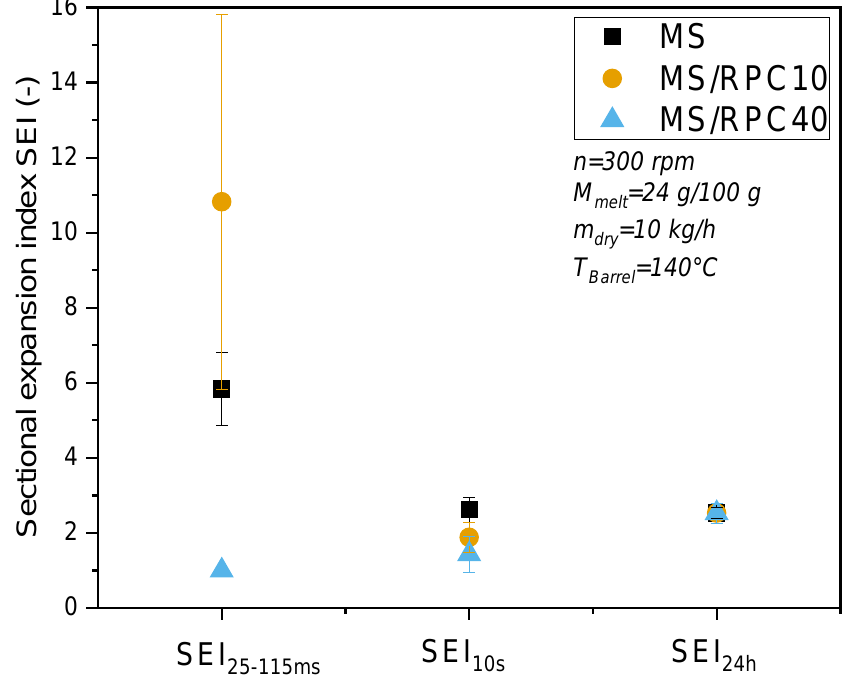
Figure 2. Initial, intermediate and final sectional expansion indices (SEI 25–115ms , SEI 10s , SEI 24h ) of maize starch (MS) extruded as a pure component or in blends with 10 or 40 g/100 g (w.b.) rapeseed press cake (RPC). Samples were processed at a barrel temperature (T Barrel ) of 140 °C, a mass flow rate (m dry ) of 10 kg/h, a moisture content (M melt ) of 24 g/100 g (d.m.) and a screw speed (n) of 300 rpm.